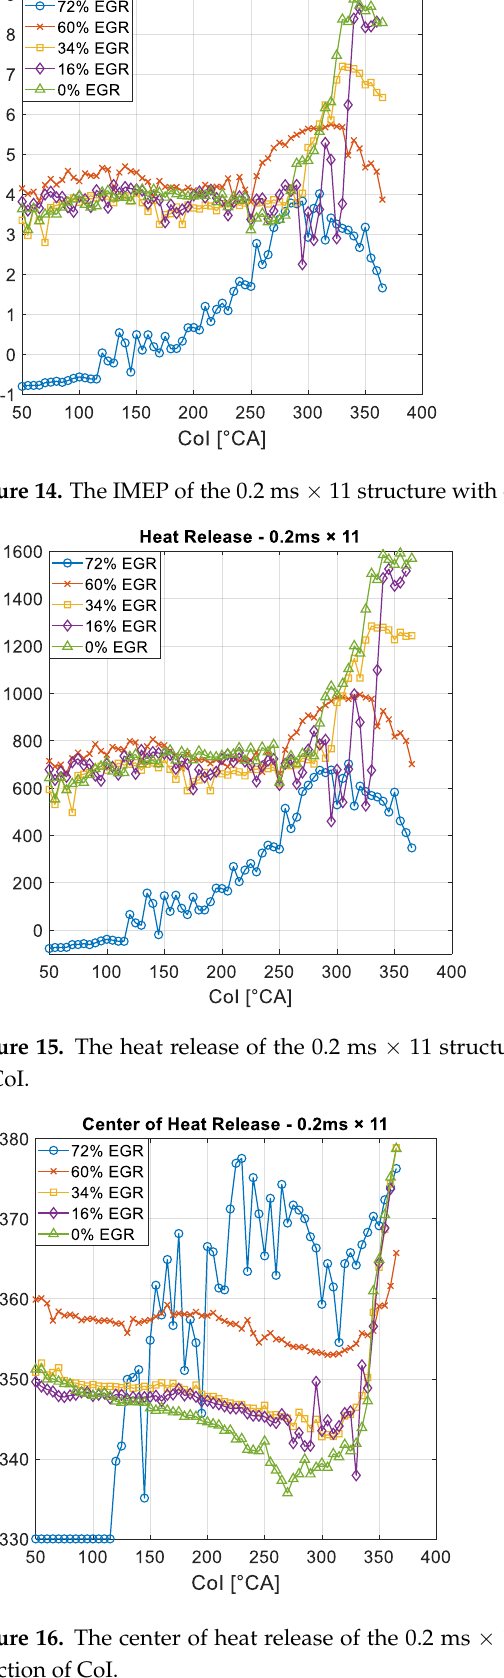
Figure 17. The pressure gradient maxima of the 0.2 ms × 11 structure with different EGR rates in the function of CoI.